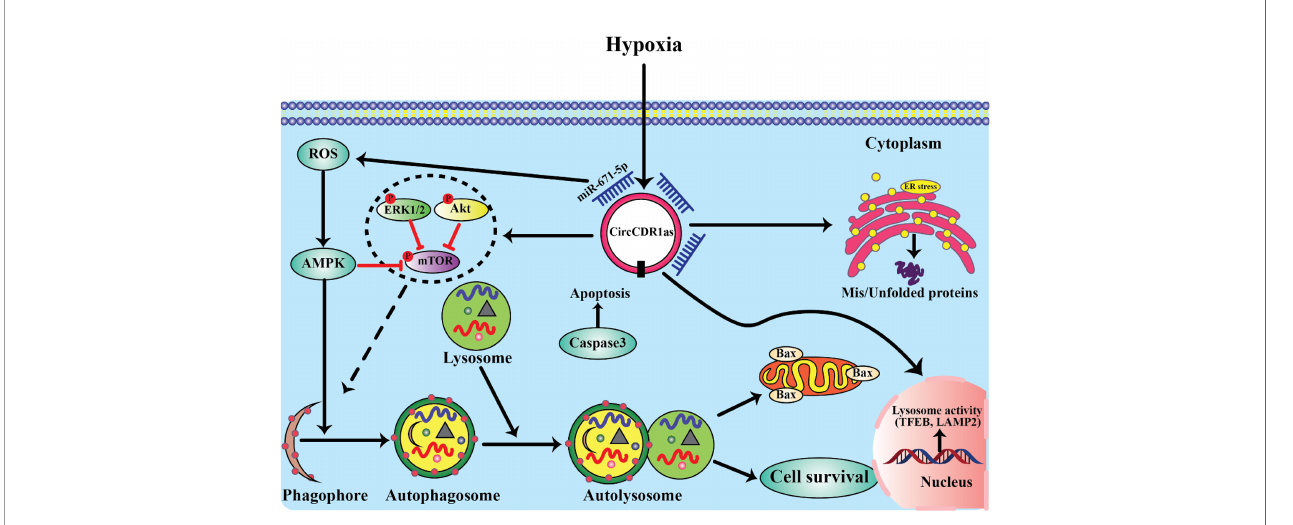
FIGURE 3 | The mechanism underlying the regulation of